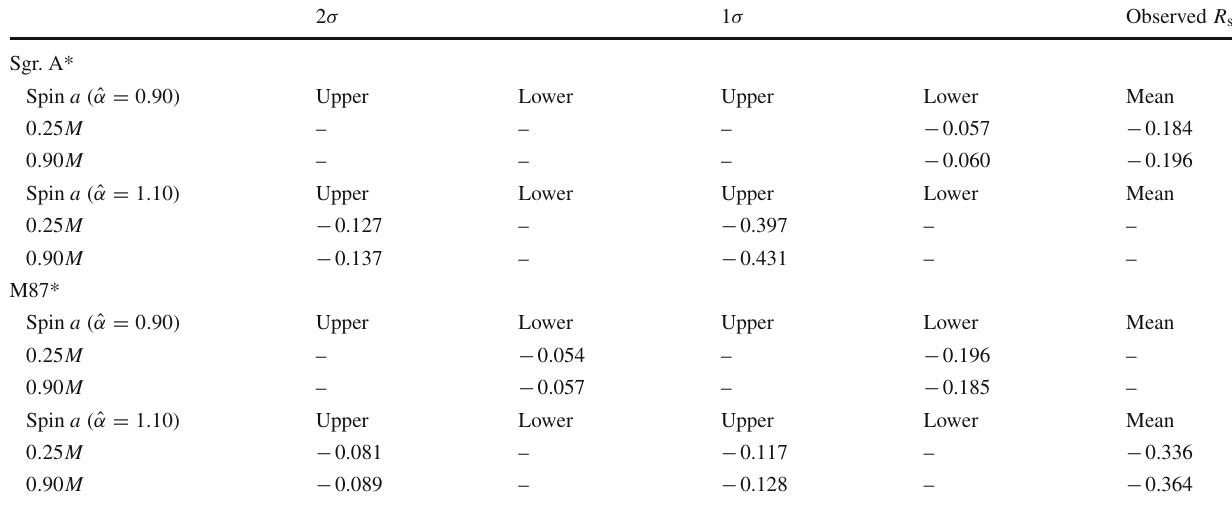
Table 2 Bounds on c 0 as read off from the curves in Fig.